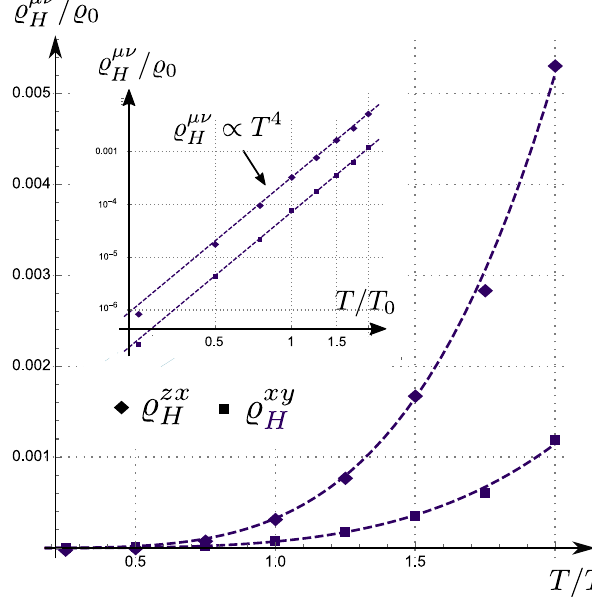
FIG. 4. Thermal Hall resistivity ϱ xy κ − 1 ϱ 0 ¼ 0 ) with respect to temperature T . The transverse mag- netization values ð m y 0 ; m z 0 Þ used for computing ϱ xy (0.0,0.05) and (0.05,0.0), respectively. Inset: log-log plot. The scaling behavior is consistent with the analysis presented in the